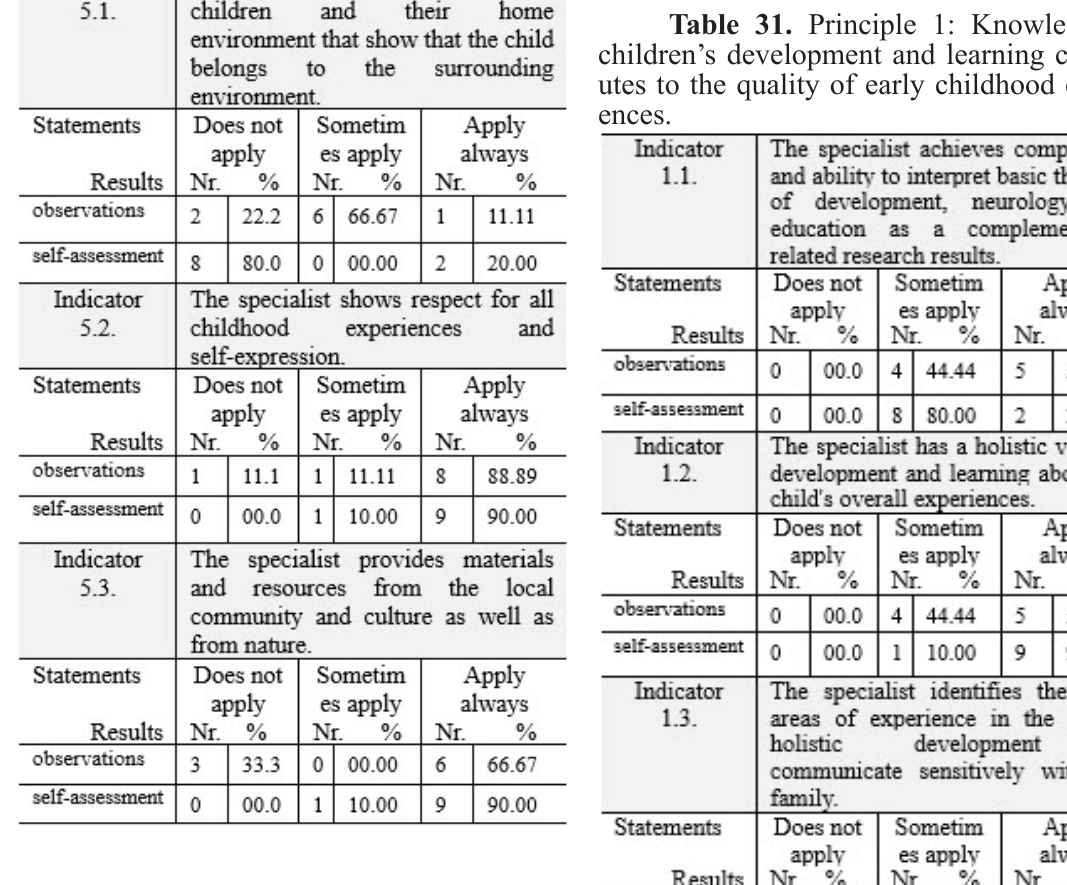
Table 31. Principle 1: Knowledge